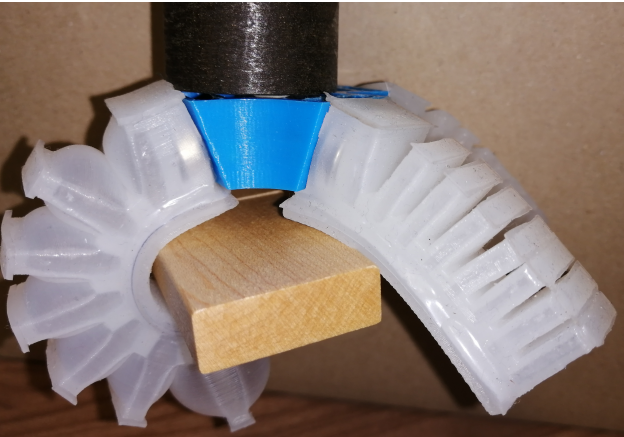
Figure 1. An example of three bending PNA’s assembled into a gripper holding a wooden